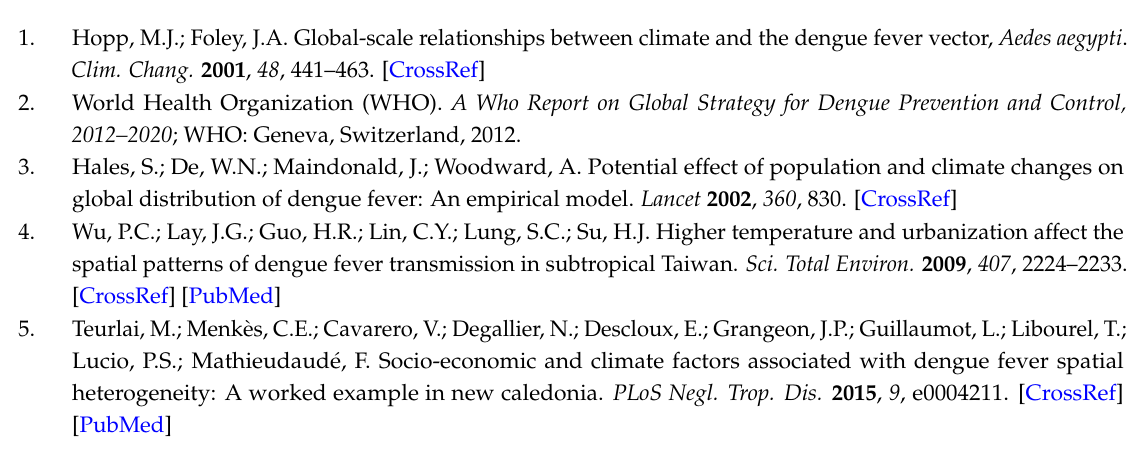
Table S1: Number of indigenous cases by gender, age and employment status in Guangzhou 2014. Table S2: Interactive impact of socio-ecological factors on dengue fever